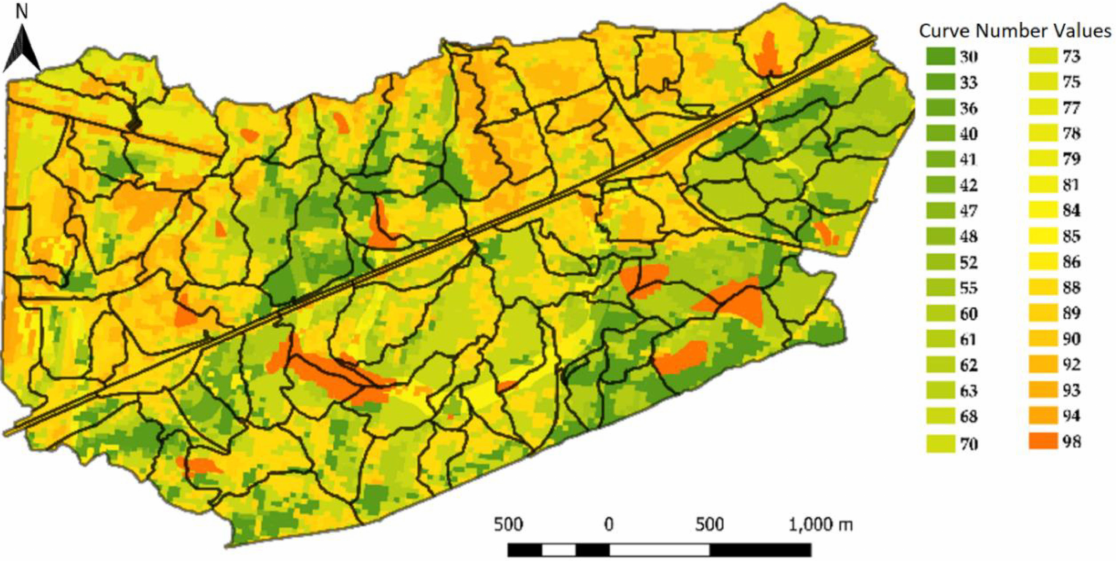
Figure 5. Curve number values within Moore’s Mill Creek watershed were calculated using the CurveNumberGenerator plugin [26] within QGIS.